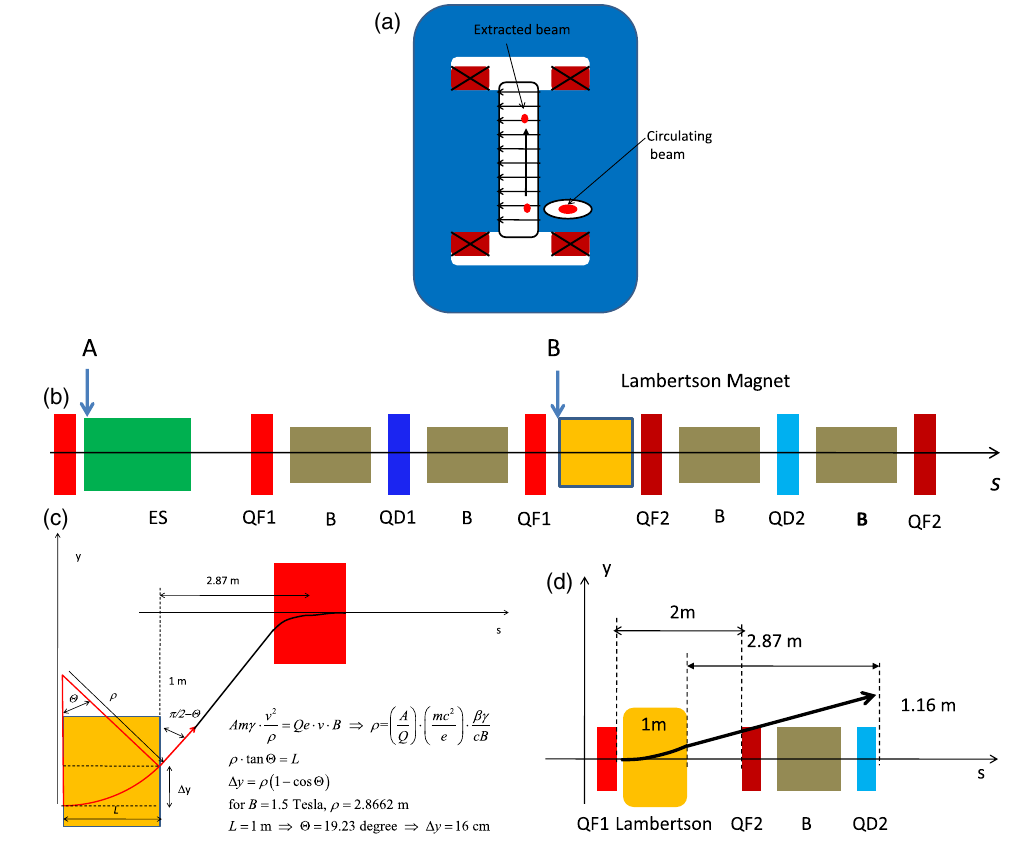
FIG. 19. (a) Cross-section of Lambertson magnet; (b) Schematic view of the extraction area with an electrostatic septum with voltage 120 kV, gap distance 3 cm, and total length 2 m A: entrance of the septum region; B: entrance of the Lambertson magnet; (c) Extraction beam orbit and downstream; (d) Extraction orbit on the vertical